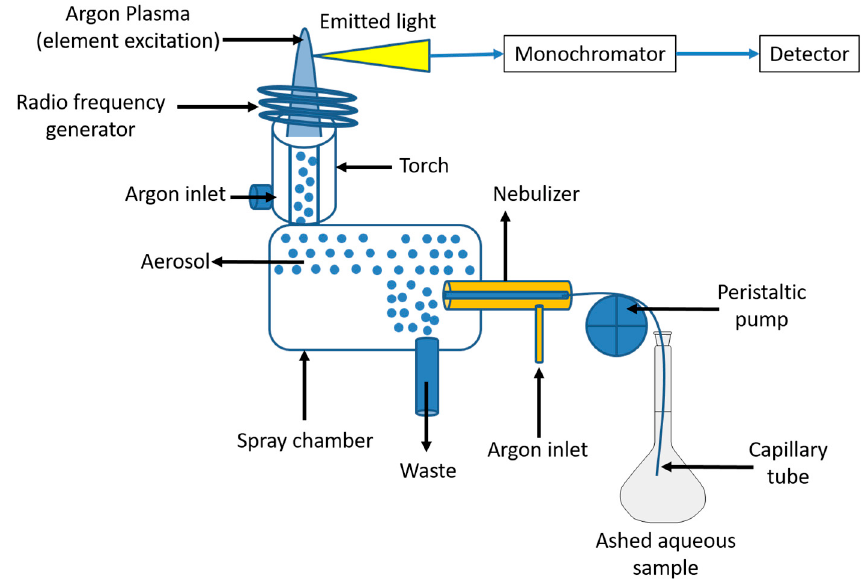
Figure 4. Inductively coupled plasma atomic Emission spectroscopy (ICP-AES) principle.